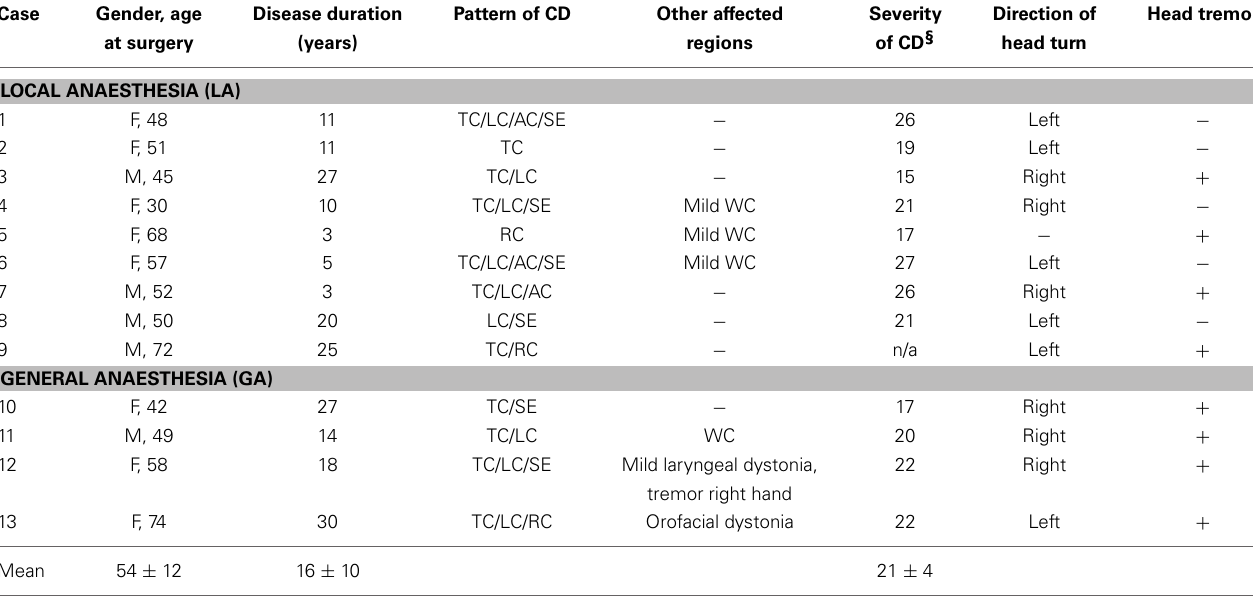
Table 1 | Clinical characteristics of CD